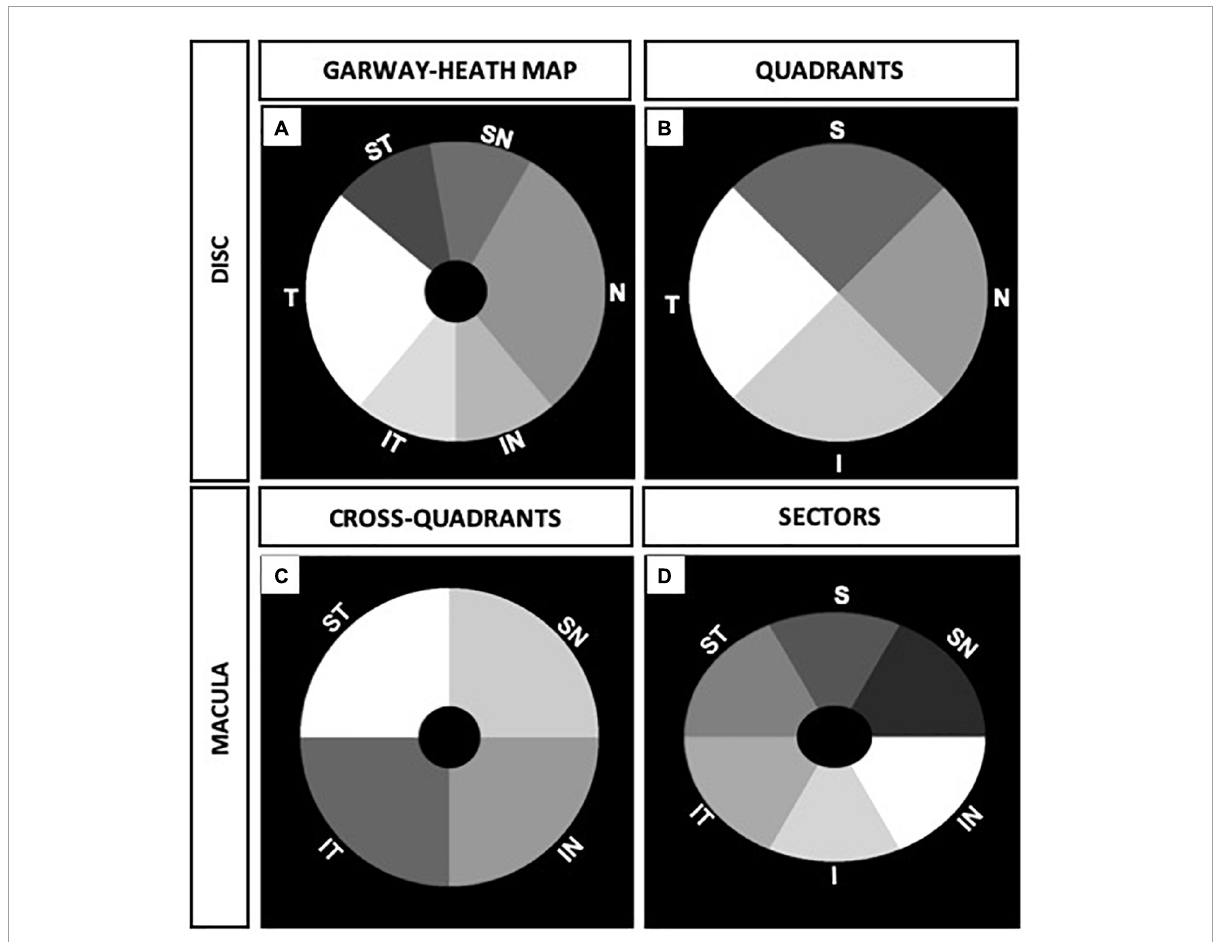
FIGURE2 Peripapillary and macular annulus masks of right eye. (A) Six sections of optic disk corresponding to modified visual field Garway-Heath map. (B) Four optic disk quadrants corresponding to retinal nerve fiber layer (RNFL) quadrants from optical coherence tomography (OCT) measurements. (C) Four cross-quadrants of macula corresponding with Visual Field quadrants. (D) Six macular sectors in ellipsoid annulus corresponding to ganglion cell complex (GCC) sectors from OCT